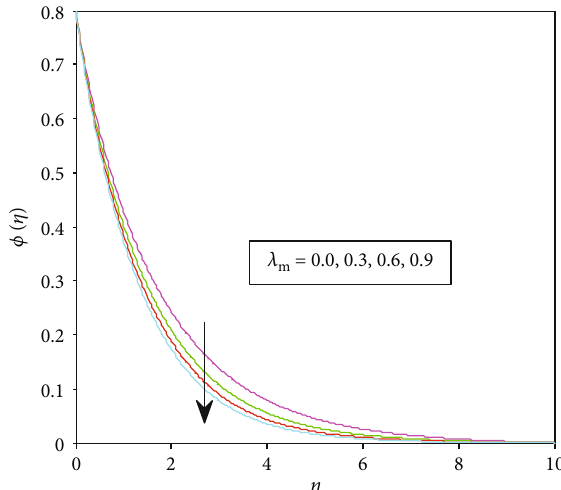
Figure 18: Concentration distribution for di ff erent values of the mixed convection parameter.